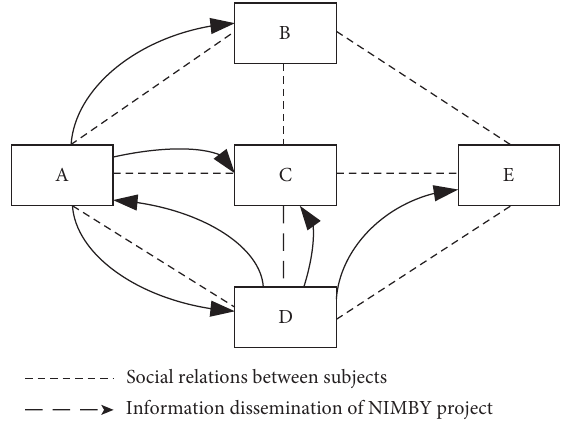
Figure 2: Information dissemination network of NIMBY